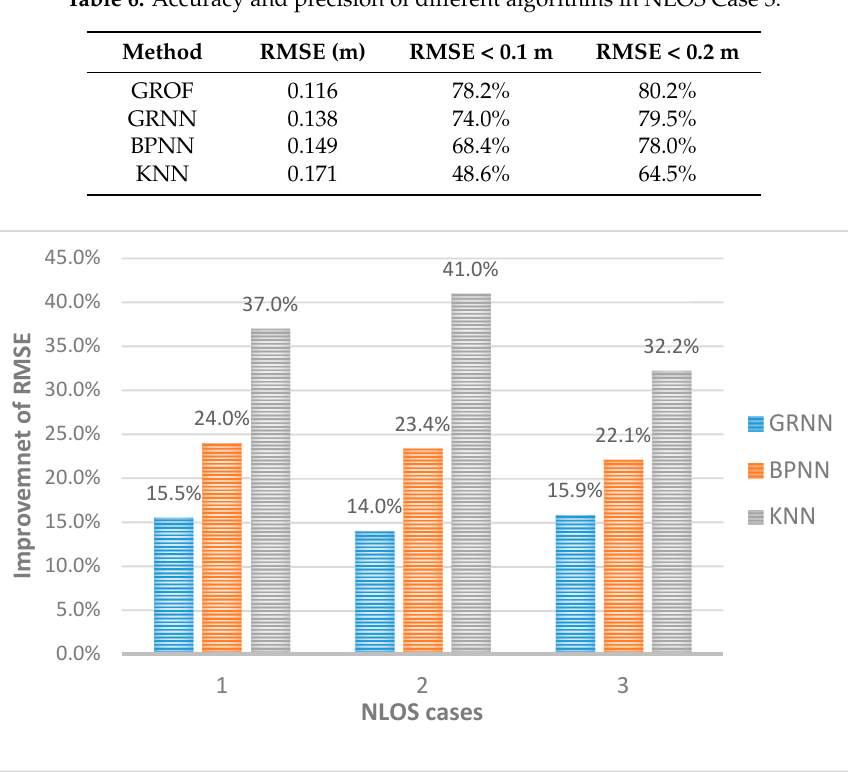
Figure 20. The RMSE improvement of GROF versus different algorithms in three NLOS cases.